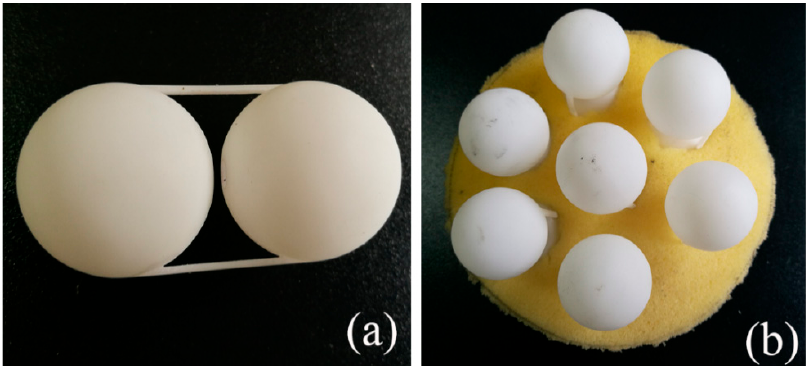
Figure 2. ( a ) The 3D printed DSSHS structure; ( b ) the fabricated specimen of DSSHS AMM.